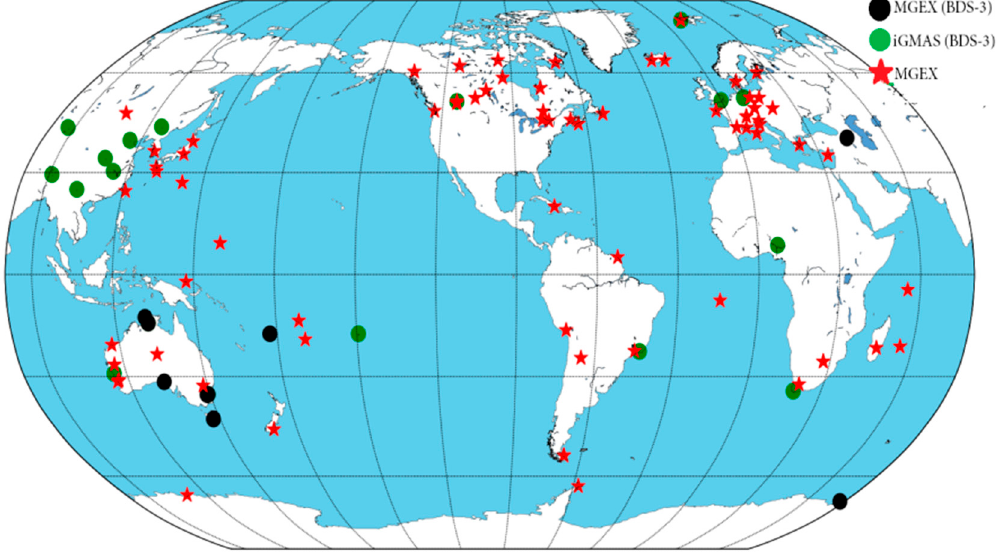
Figure 8. Distribution of selected stations for both ultra-rapid and rapid orbit determination. MGEX, Multi-GNSS Experiment; iGMAS, international GNSS Monitoring and Assessment Service.